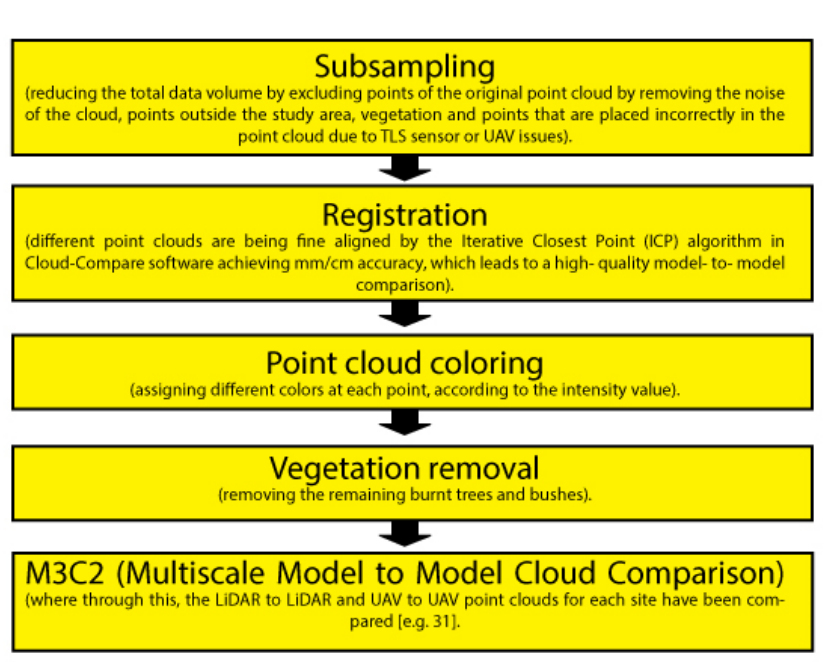
Figure 3. Point cloud processing — CloudCompare workflow.